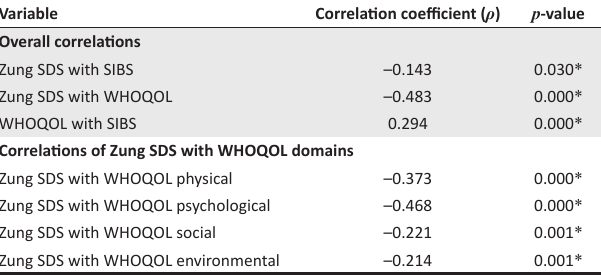
TABLE 3: Correlation coefficients for Zung SDS, SIBS and WHOQOL.